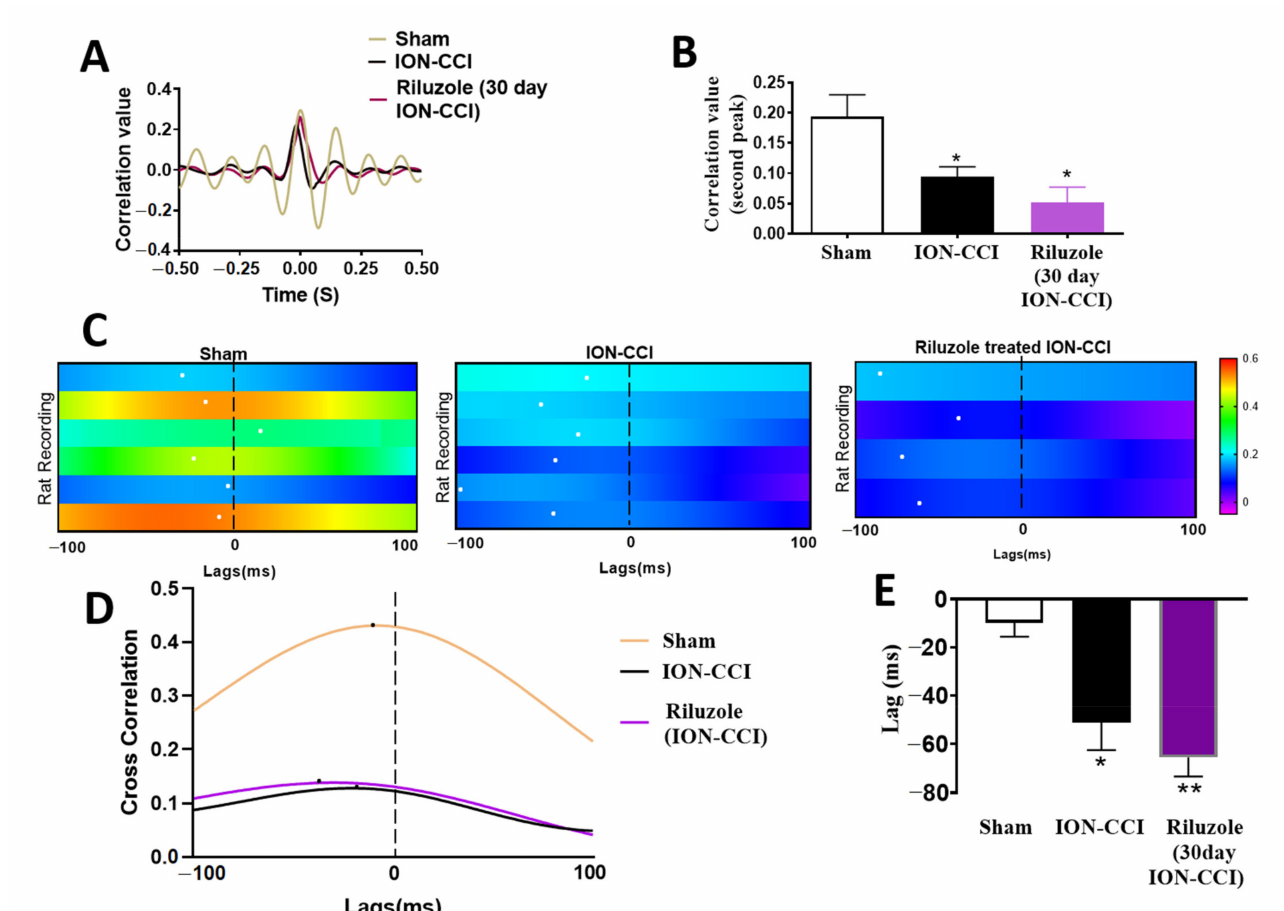
Figure 5. Disrupted BLA-ACC LFP theta coherence and information flow in ION-CCI rats. ( A ) Cross-correlation analysis of theta-filtered LFP recorded in the BLA and ACC revealed a reduction of synchronization in theta band in ION-CCI rats compared to sham rats. ( B ) Averaged cross-correlation value of second positive peak, which represents synchronization of theta band LFP between the BLA and the ACC, showing that the synchronization was decreased in ION-CCI rats. Riluzole treatment in ION-CCI rats also did not rescue synchronization between the BLA and the ACC. ( C ) Lag estimate for sham rats (left; n = 6), ION-CCI rats (centre; n = 6), and ION-CCI rats with riluzole treatment (n = 4) by cross-correlation of instantaneous amplitude of field potential recorded from BLA and ACC. Warmer colors indicate higher cross-correlation peaks or greater phase-locking strength. White dots represent the lags at which the cross-correlation coefficient peaks occurred. ( D ) Representative distributions of cross-correlation coefficient at different lags from examples of one ION-CCI rat (red line) and one sham rat (blue line). Dark stars show the peaks of the cross-correlation. ( E ) The reduction of mean lags at the peak in ION-CCI rats and ION-CCI rats with riluzole treatment were compared to sham rats. * p < 0.05, ** p < 0.01 by one-way ANOVA followed by Bonferroni adjusted t